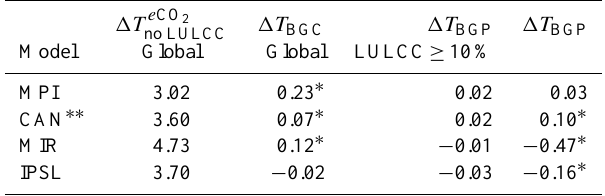
2100: globally and over areas where LULCC ≥ 10% of the grid cell. The asterisk ( ∗ ) marks values with statistical significance ( ≥ 95%) of a Student’s t test accounting for autocorrelation. The tempera- ture change over the 21st relative to 2006 century due to fossil fuel forcings only is given by 1T e CO 2 (L1B no LULCC